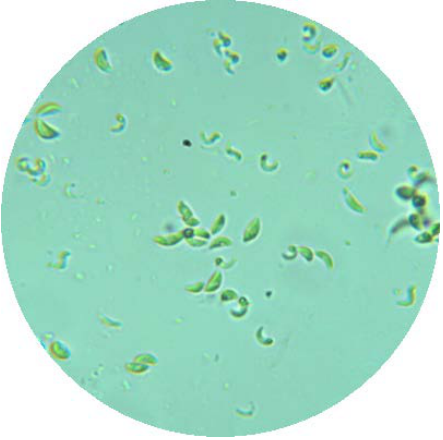
Figure 1. Light microscopy image of Monoraphidium sp. obtained during cultivation.